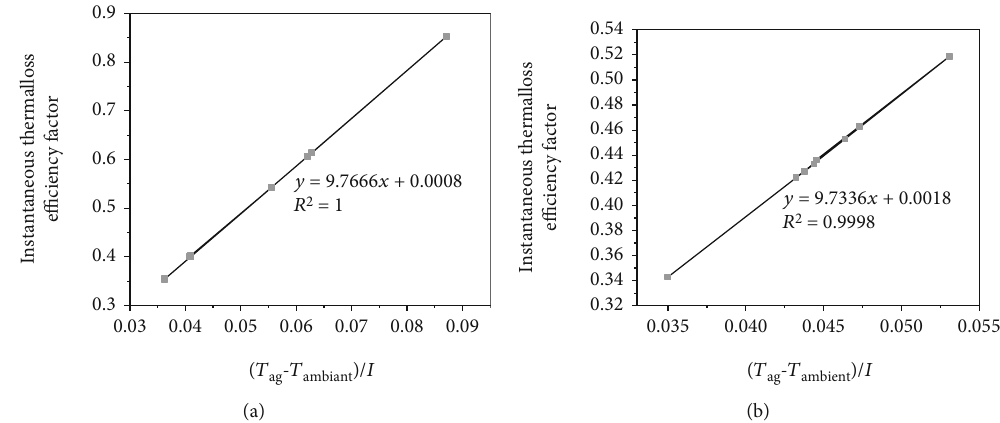
Figure 11: Characteristic curve for uneven-span greenhouse dryer at (a) day-1 and (b)